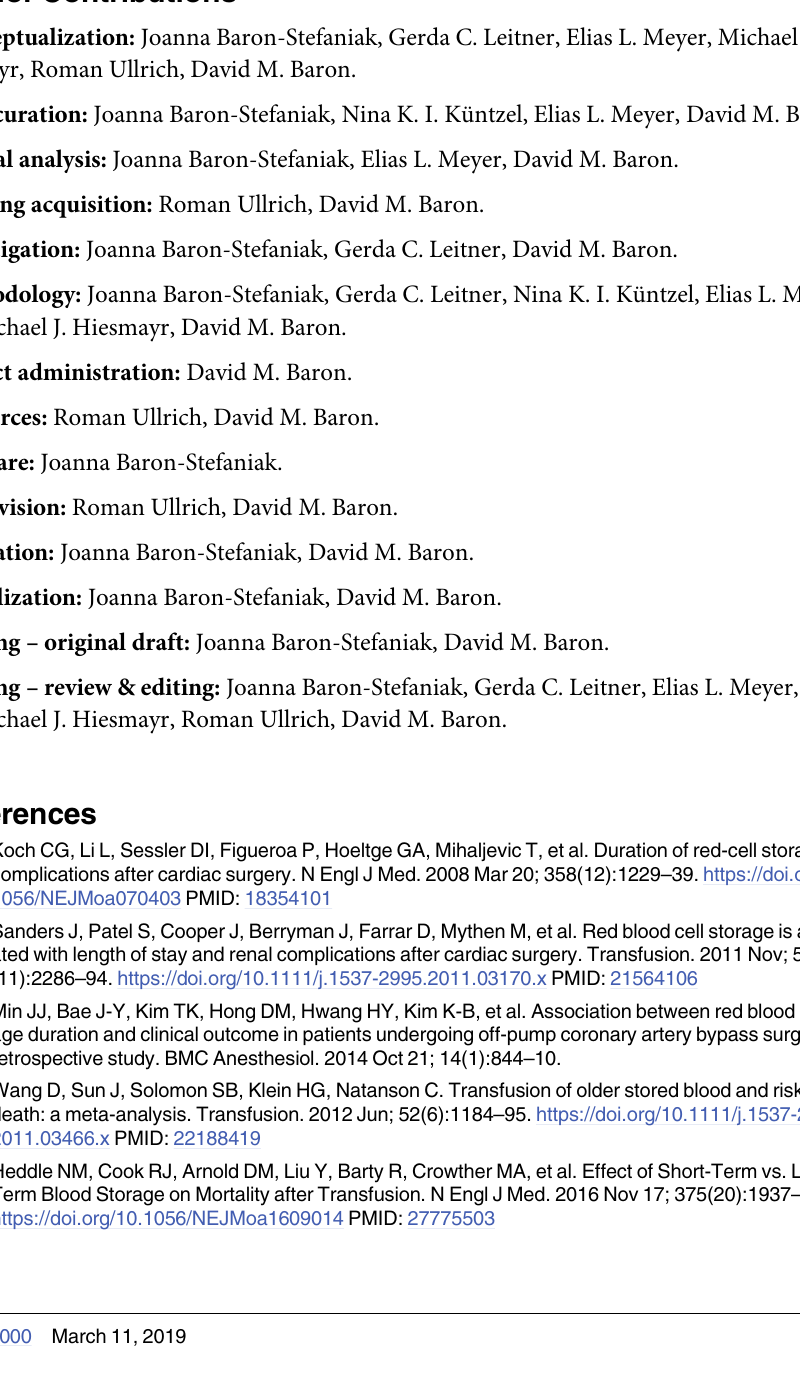
S1 Study Protocol. English translation of the study protocol. (PDF) S2 Study Protocol. Original German version of the study